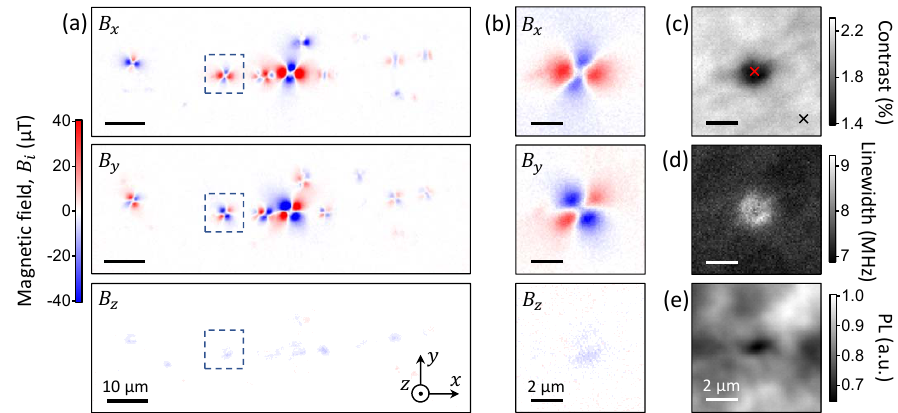
(g) Figure 2. ( a ) Maps of the magnetic field components B x , B y and B z (from top to bottom) showing multiple spots corresponding to magnetic nanoparticles at the diamond surface. ( b ) Magnetic field maps of a single ferromagnetic nanoparticle, corresponding to the dashed box drawn in ( a ). ( c , d ) Maps of the ODMR contrast ( c ) and linewidth ( d ) of the lowest-frequency resonance in the ODMR spectrum, for the same region as in ( b ). The red and black crosses in ( c ) indicate the locations of the ODMR spectra shown in Figure 1b, with matching colours. ( e ) Corresponding NV photoluminescence (PL)